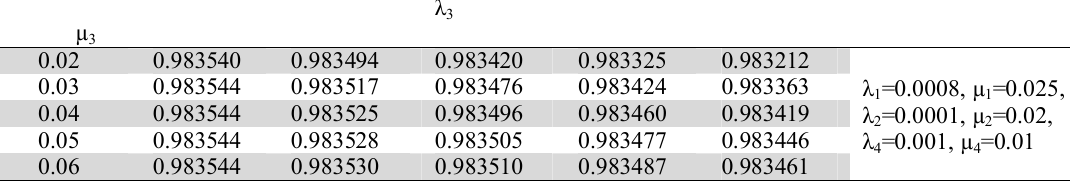
) on Availability (A ) d v. ) → v.